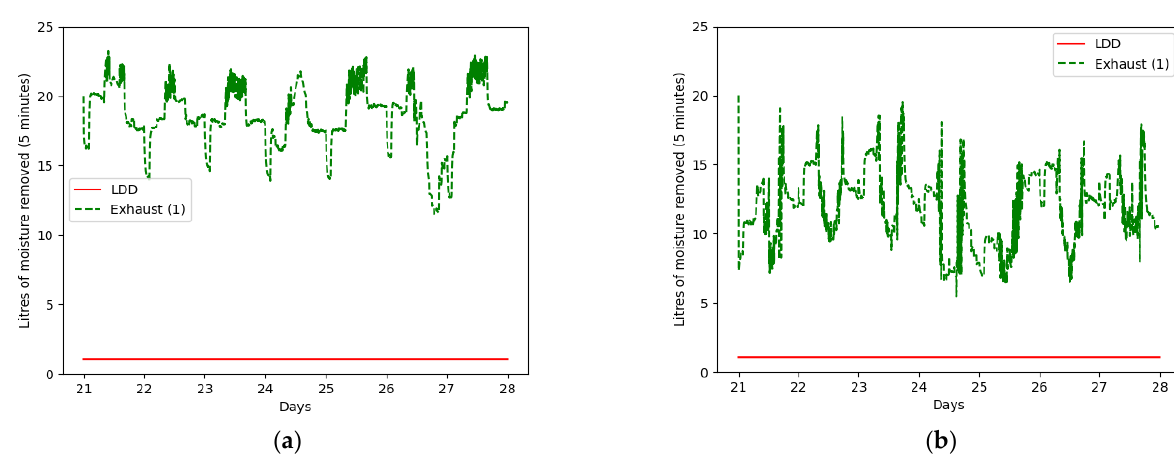
Figure 6. Moisture removal capacity, in units of liters per five-minute period, of LDD and exhaust fan in ( a ) winter (21 – 28 December) and ( b ) fall (22 – 29 September) conditions. Table 10. Comparison between experimental data and simulation results for LDD spring test case. Average RH MRD Status